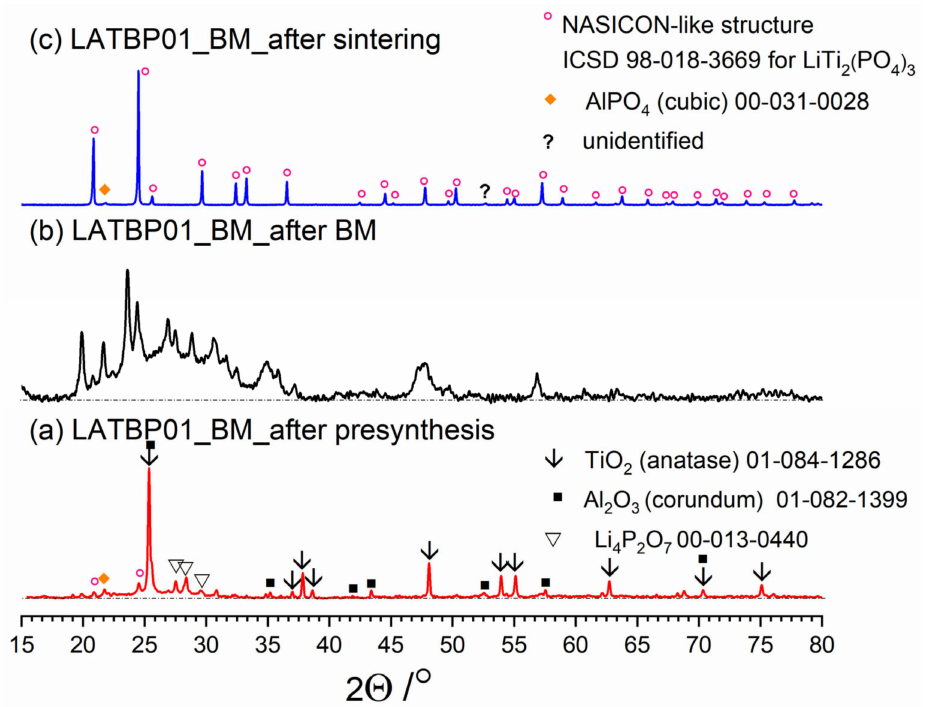
Figure 4. Diffractograms presenting different stages of LATBP01_BM_ceramic formation: ( a ) after presynthesis at 350 ◦ C for 3 h; ( b ) after ball-milling at 600 rpm for 72 h; ( c ) after heat treatment at 900 ◦ C for 12